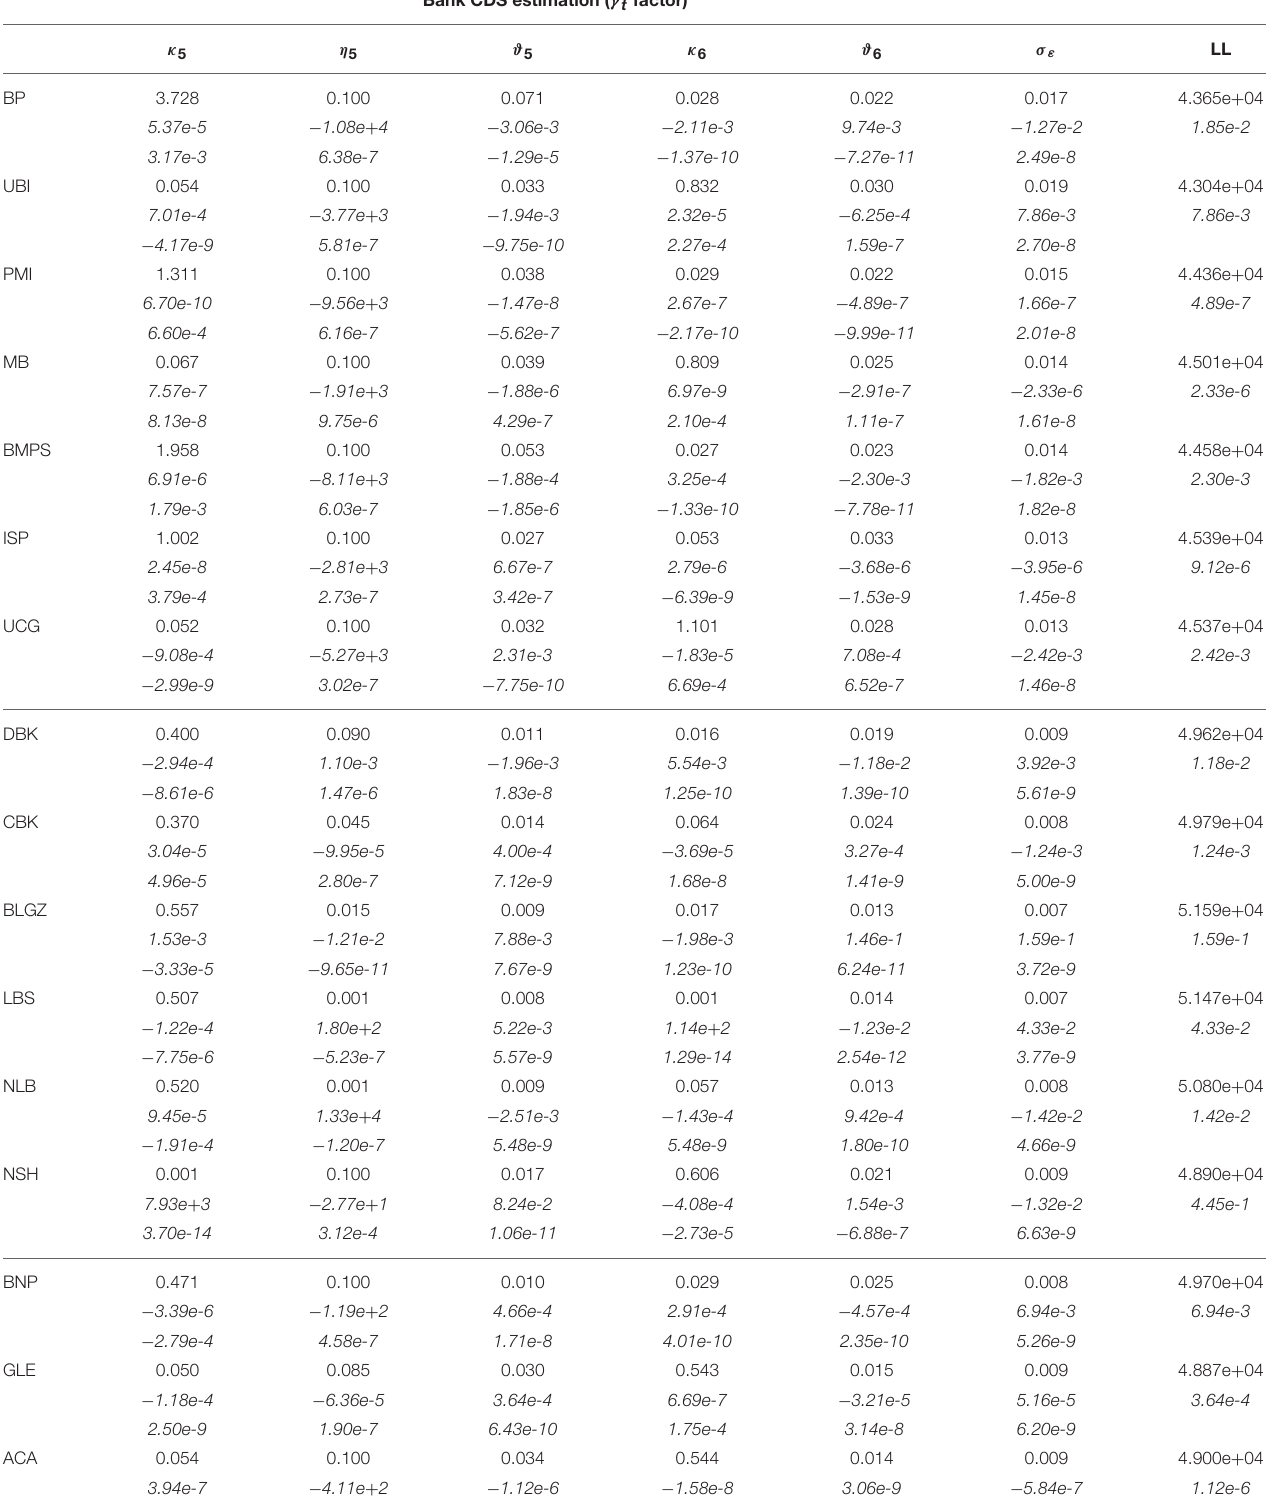
TABLE 9 | Estimated parameters of the multi-factor Vasicek